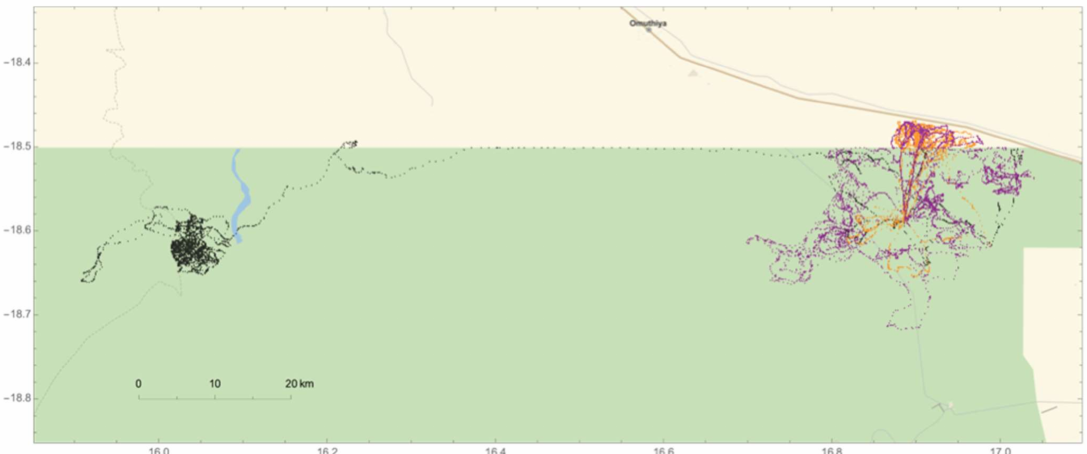
Figure 7. Movement patterns of adult elephant #264 across the northeastern region of Etosha National Park over a nine-month span in 2010. Black points represent movements during the three-month period before the onset of musth (May–July). Orange points represent #264 (cid:48) s movements during musth (31 July–31 October), and purple points depict movements during the post-musth period (November–January). During the post-musth period, #264 spends much of his time utilizing the entire northeast region of the